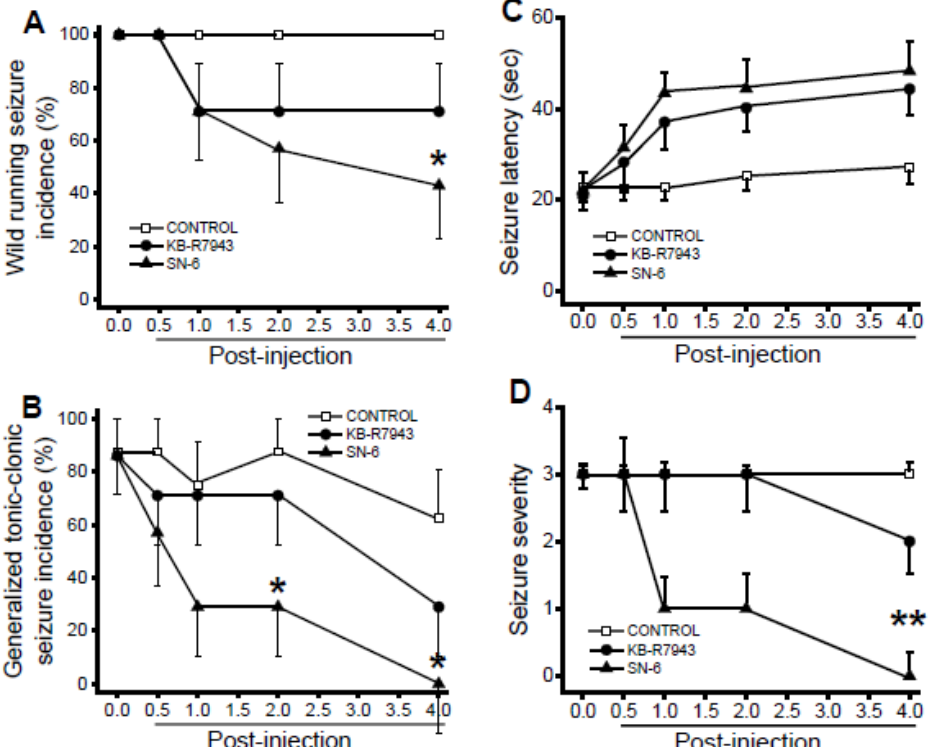
Figure 3. Effects of acute SN-6 or KB-R7943 treatment at the dose of 3 mg/kg on the occurrence of acoustically evoked AWS susceptibility. The putative antiseizure effects of the inhibitor NCX1 rev (SN-6, 3 mg/kg, p.o.) and NCX3 rev (KB-R7943, 3 mg/kg, p.o.) were evaluated at different posttreatment time points of 0.5-, 1-, 2-, and 4-h in rats exhibiting AWSs. ( A ). SN-6 (but not KB-R7943) treatment significantly reduced the incidence of WRSs component of WRSs. ( B ). SN-6 (but not KB-R7943) significantly reduced and suppressed the incidence of GTCSs component of AWSs by the 2nd and 4th h post injection, respectively. ( C ). Both SN-6 and KB-R7943 treatments not considerably delayed the onset of seizure. ( D ). SN-6 (but not KB-R7943) treatment suppressed the AWS severity. Data from the incidence of WRSs and GTCSs, seizure latency, and seizure severity are presented and analyzed as described in Figure 2. The summary of data was obtained from eight rats in the control-treated group and seven rats per group when SN-6 or KB-R7943 was used. * p < 0.05, ** p <